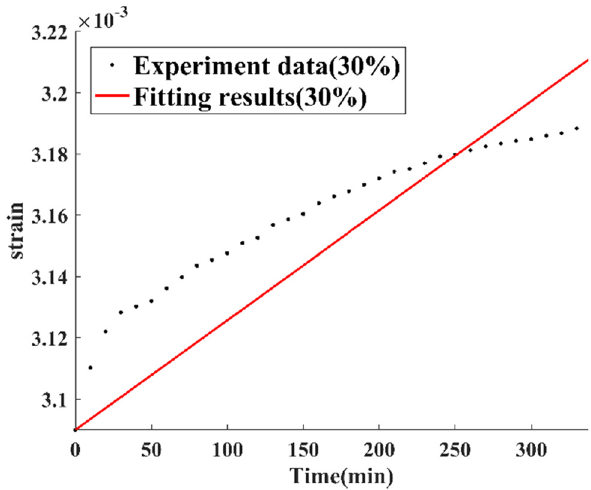
Figure 10: Fitting results based on the conventional Maxwell model and 50% stress level.